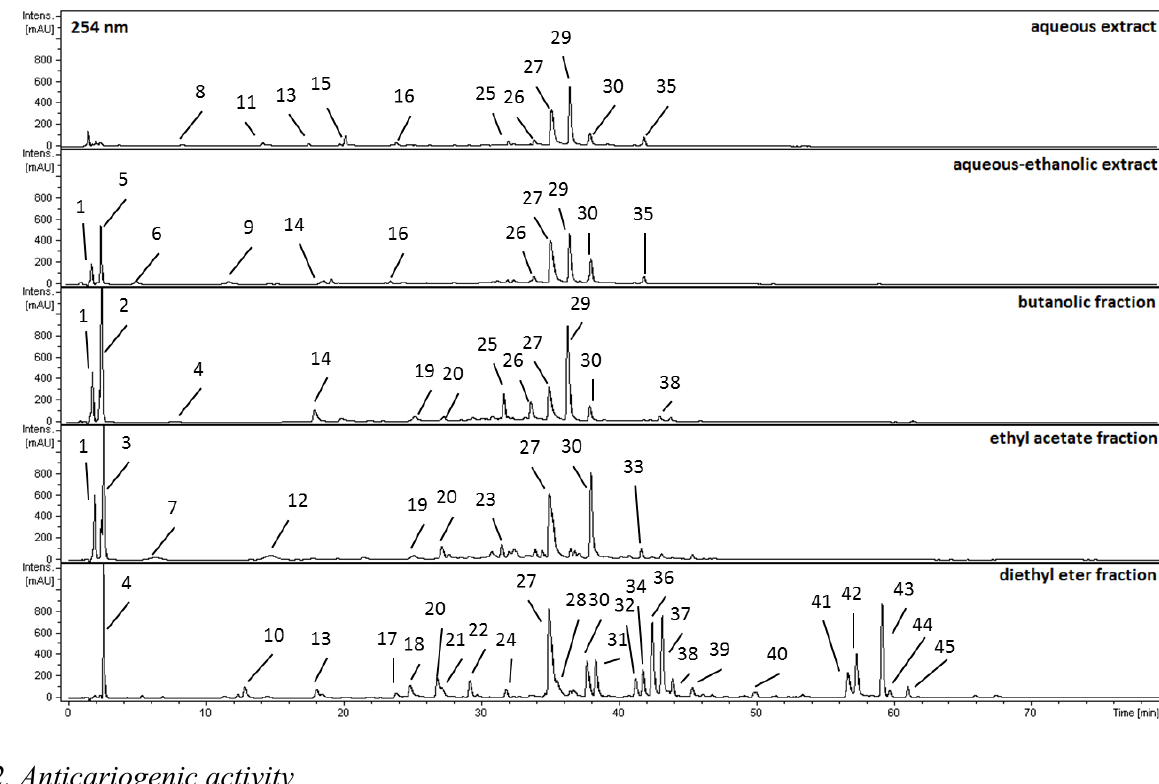
Figure 1. HPLC-DAD-MS 3 total ion chromatogram of analyzed extracts and their subfractions acquired at 254 nm. For chromatographic conditions see Experimental section. Numbering of the peaks is the same as in Table